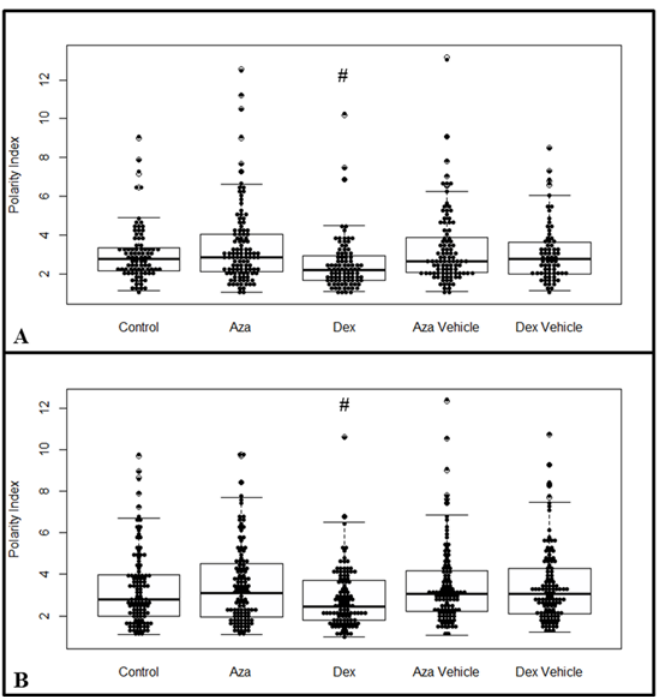
Fig 4. Cell Polarity Index. MSCs were cultured for 24 h (A) or 7 d (B) with or without AZA 1 μ M or DEX 10 μ M, and their polarity index was measured according to S1 Fig. PI values were obtained from 80 – 100 cells ( n = 4), and the results showed that DEX treatment induced a more rounded cell shape ( # P < 0.05), while AZA showed a tendency to induce more elongated cells when compared to the control group. Graphs present the median value between the lower and upper quartiles, while showing the variability outside this range. The polarity index assay was analyzed using Kruskal-Wallis post-hoc Dunn.